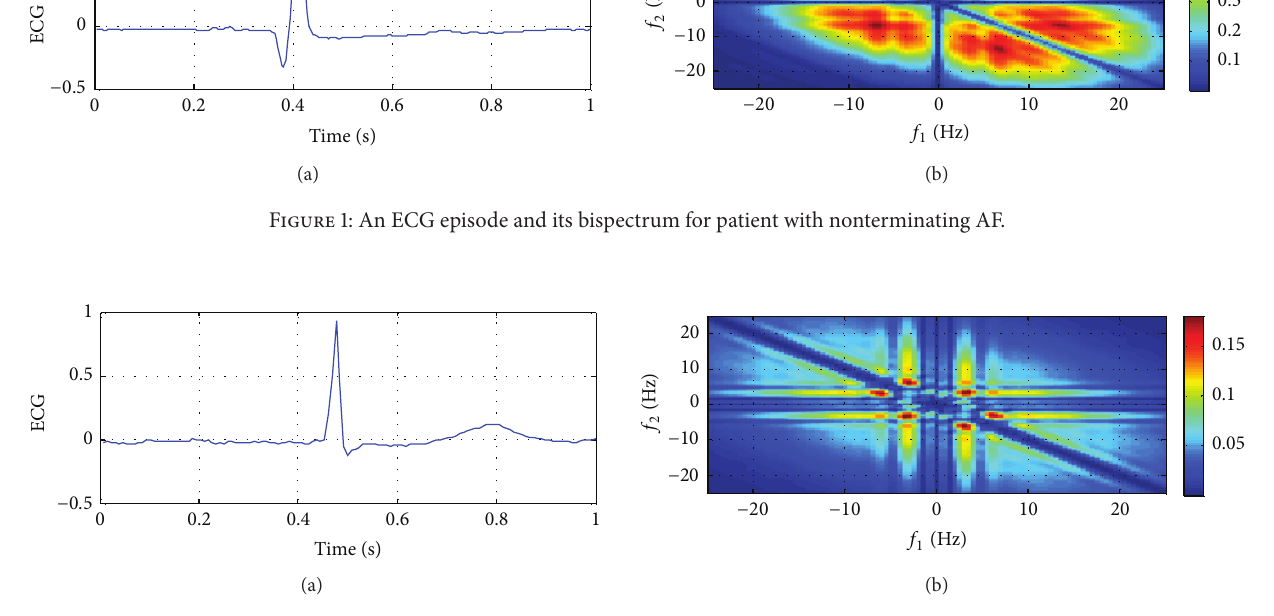
Figure 2: An ECG episode and its bispectrum for normal